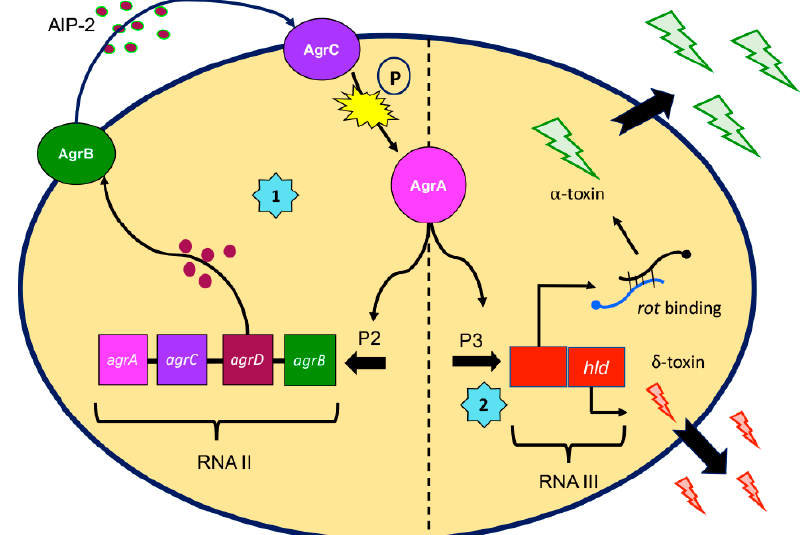
Figure 1. Schematic of the agr quorum sensing system in Staphylococcus aureus . AgrA is the response regulator in a two-component system that acts as a transcription factor, modulating toxin production. (1) AgrA activates transcription from the P2 promoter, driving expression of RNAII, an operon consisting of four agr genes. AgrB is a membrane-bound permease that processes AgrD, a pre-signal peptide, and releases it as AIP-2 (auto-inducing peptide 2). AIP-2 is sensed by AgrC, a membrane-bound histidine kinase that is part of the two-component signaling system. AgrC phosphorylates AgrA, activating it, leading to a positive feedback loop. (2) Activated AgrA also drives transcription from the P3 promoter, driving expression of RNA III, the effector of the QS system. RNA III directly encodes for delta toxin ( hld ) and also binds to repressor of toxin ( rot ) transcript, allowing for toxin production by inhibiting rot translation. RNAIII also binds to a number of adhesin-related genes to similarly block their translation.